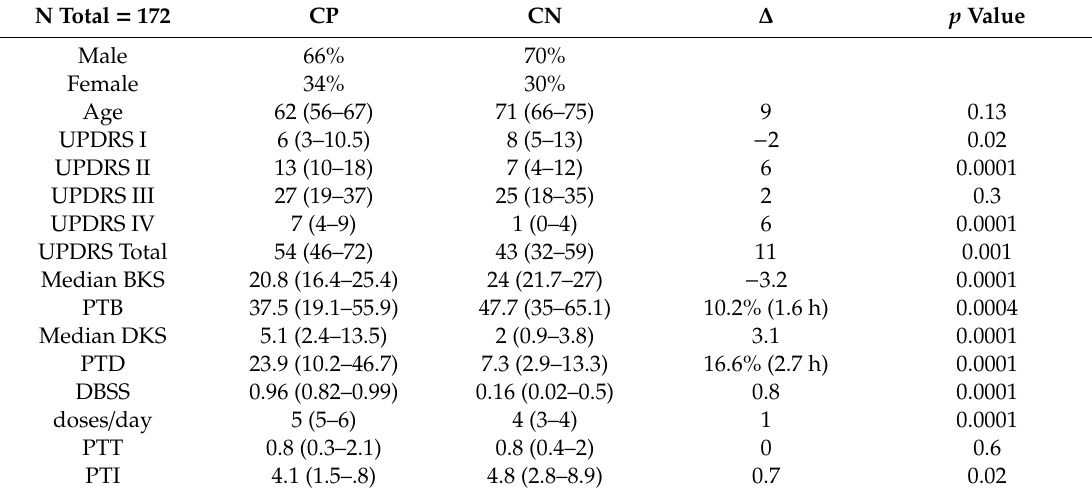
Table 1. Comparisons of the clinical and Parkinson’s KinetiGraph (PKG) characteristics of people with Parkinson’s (PwP) who were classified according to whether they met the clinical criteria for device-assisted therapies (DAT) (criteria positive (CP)) or did not (criteria negative (CN)) for